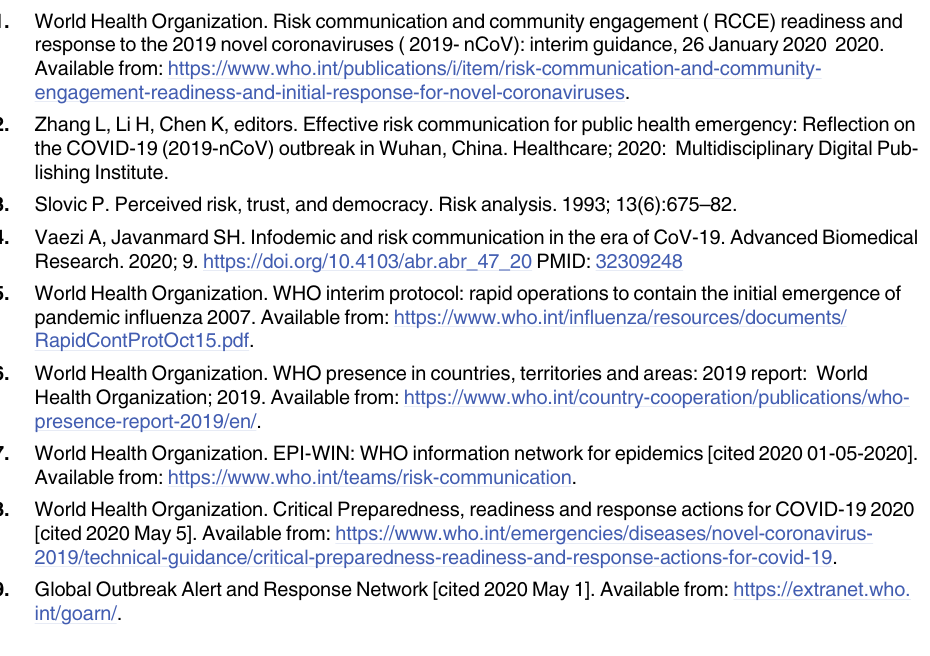
S1 Table. Classification of level of education into low/medium/high